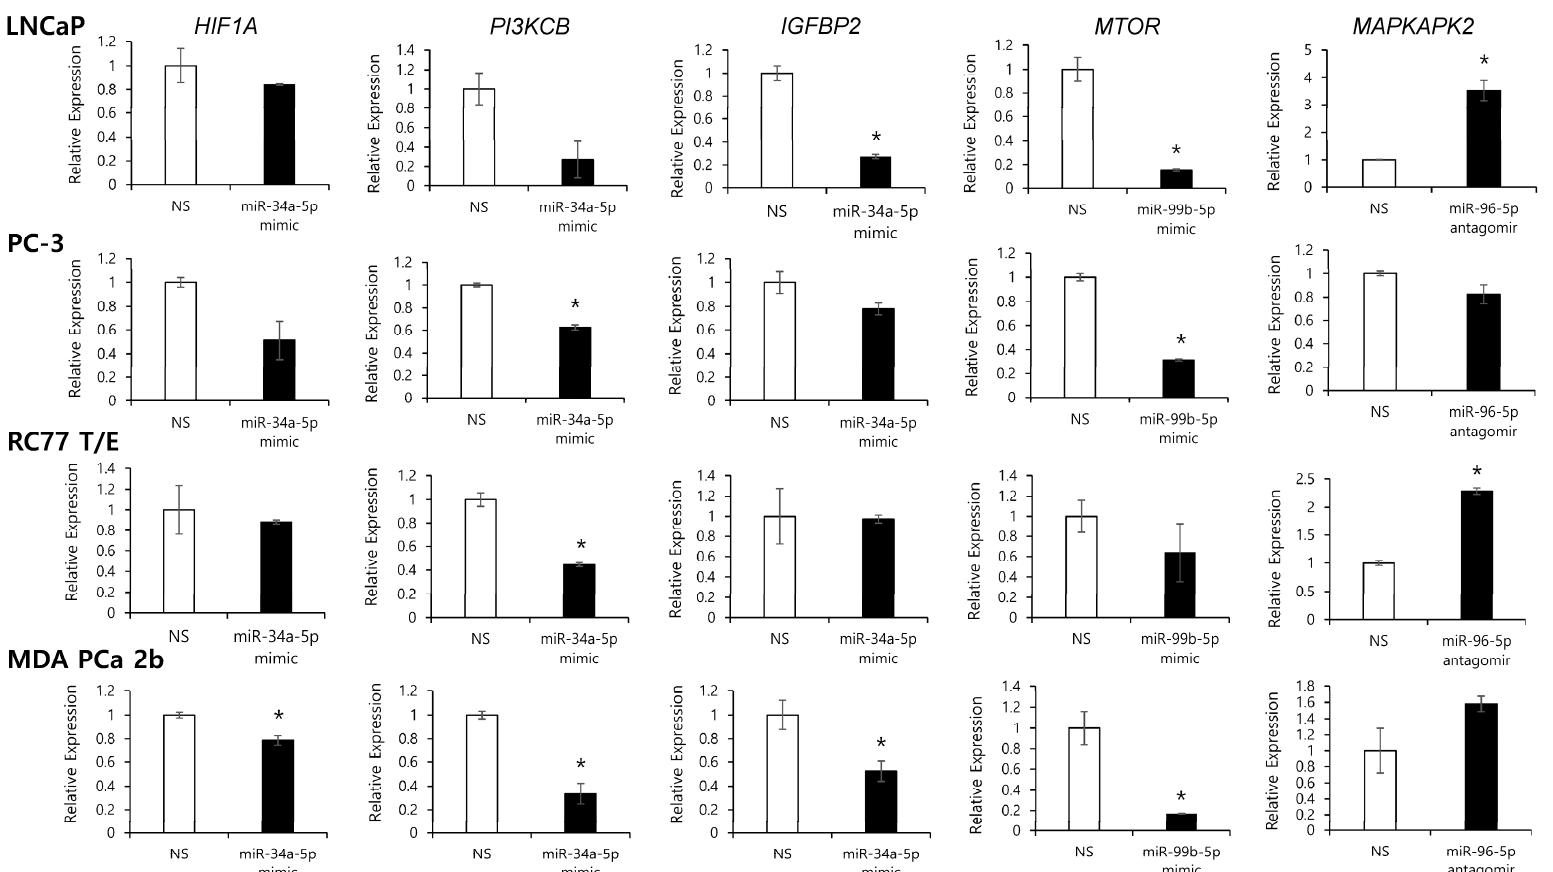
Figure 3. Modulation of miRNA expression affects the transcriptional regulation of its target genes in EA and AA PCa cell lines. RT-qPCR analysis of MTOR , PIK3CB , HIF1A , IGFBP2 and MAPKAPK2 expression in EA and AA PCa cell line models. Relative expression levels of MTOR , PIK3CB , HIF1A , IGFBP2 and MAPKAPK2 were shown in EA PCa (LNCaP and PC-3) and AA PCa (RC77 T/E and MDA PCa 2b) cell lines transfected with nonsense scrambled miRNA (NS), miRNA mimic or antagomir (miR-34a-5p mimic, miR-99b-5p mimic, or miR-96-5p antagomir). Data were presented as mean ± SEM of n = 3–4 independent RT-qPCR experiments, with technical triplicates for each independent experiment. The significance (* p < 0.05 in miRNA mimic or antagomir vs. NS) was determined based on student’s t -test.